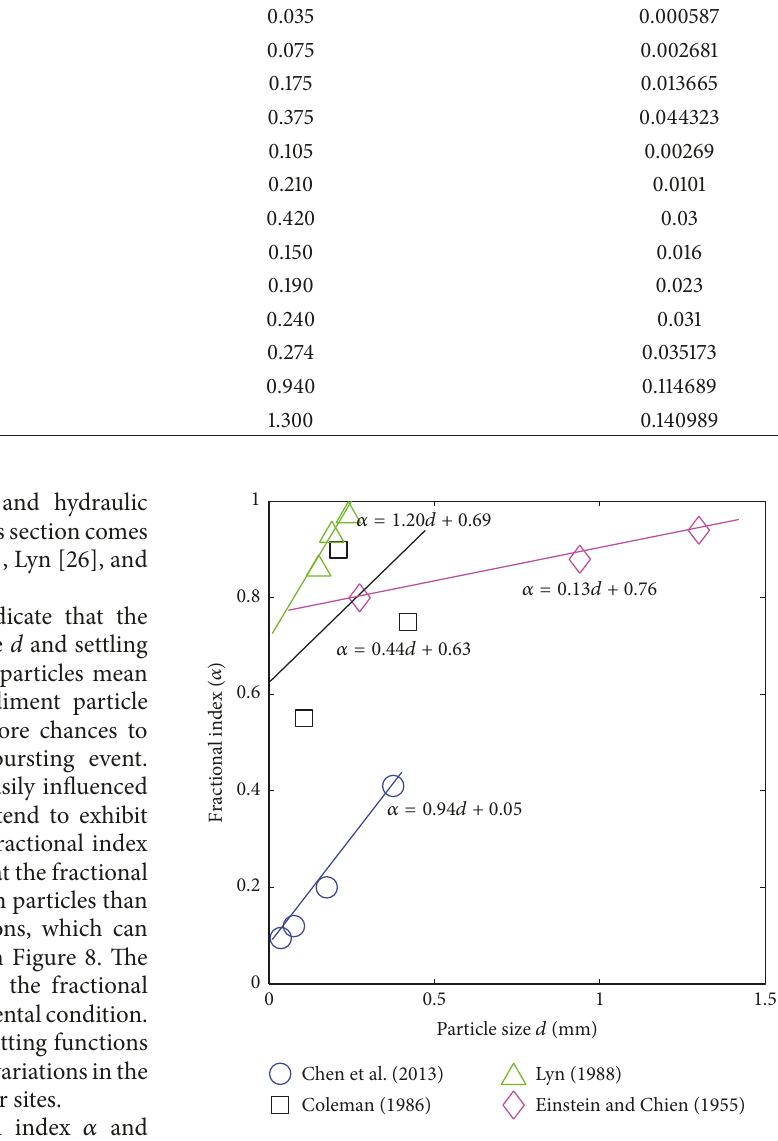
Figure 8: The relationship between the fractional index 𝛼 in the fADE model and the particle size d . The best-fit functions are obtained using the least square